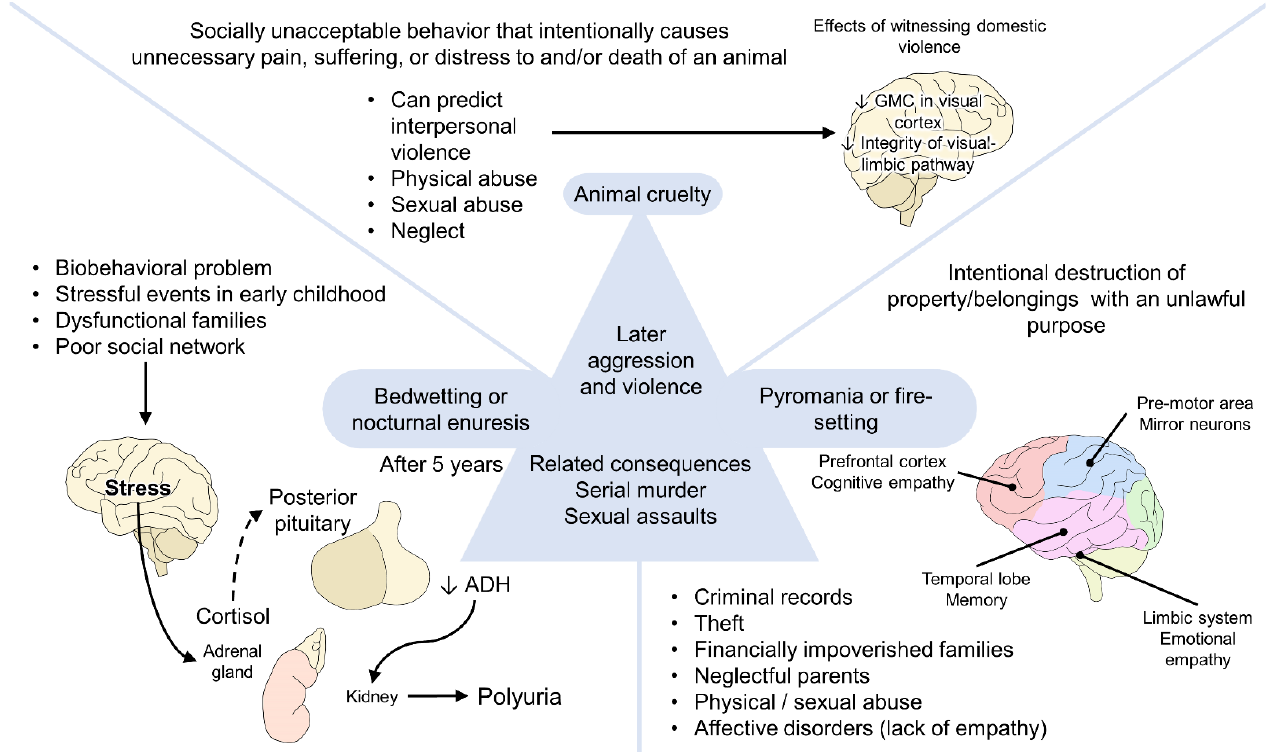
Figure 4. McDonald triad consists of bedwetting (nocturnal enuresis), pyromania, and animal abuse. ADH: antidiuretic hormone: GMC: gray matter concentration. ADH: antidiuretic hormone: GMC: gray matter